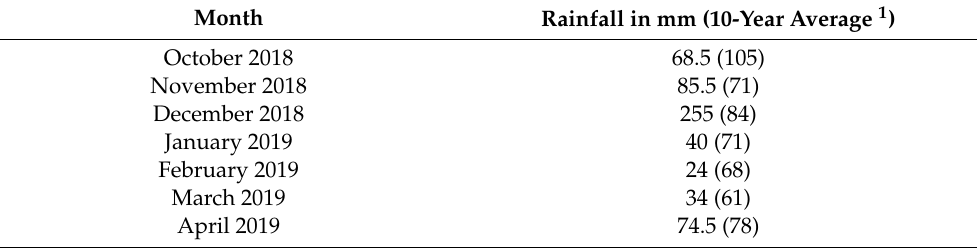
Table 9. Validated monthly rainfall approximately 2800 m west of the center of the